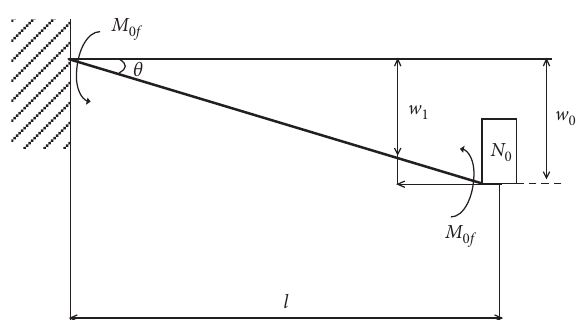
Figure 3: Displacement field of a fully clamped RC beam with a heavy striker at its